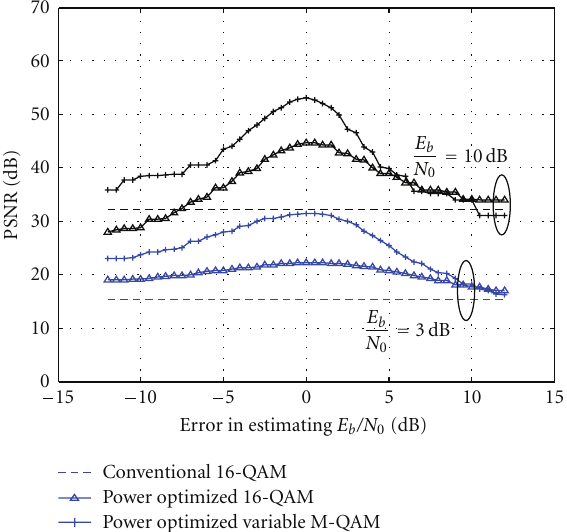
Figure 7: Sensitivity of PSNR to estimation error in E b /N 0 .